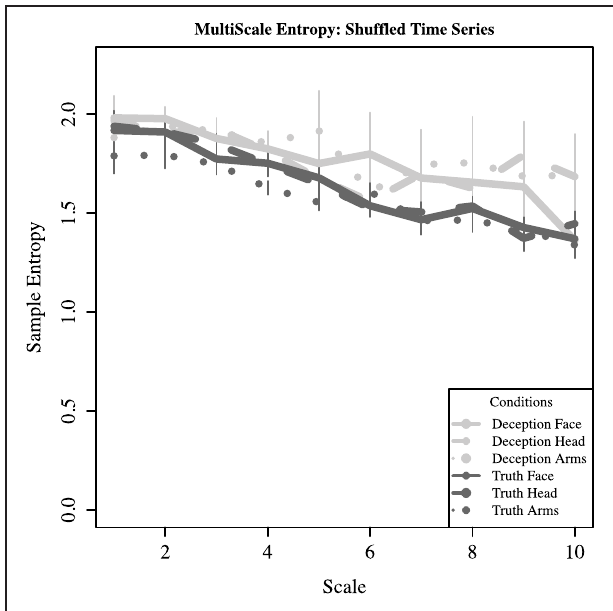
FIGURE 10 | For shuffled time series (randomized across bins of 2000ms), mean sample entropy and standard error is plotted across increasing scale lengths